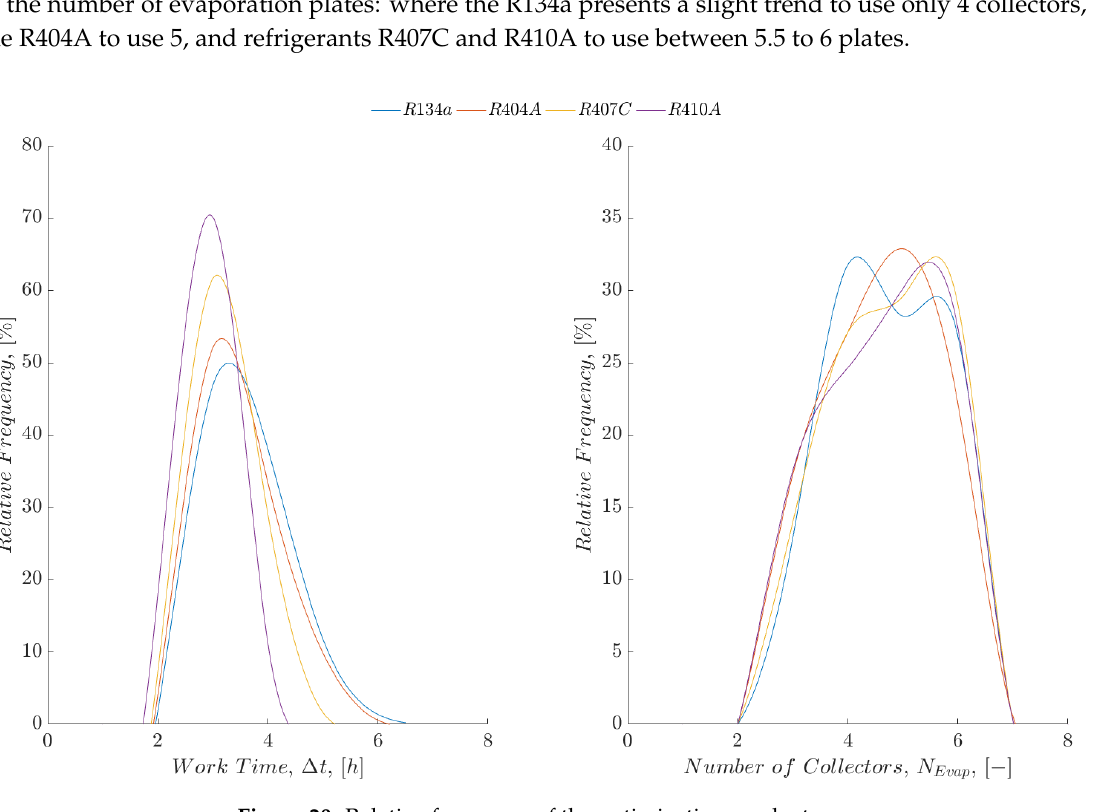
Figure 20. Relative frequency of the optimization products.